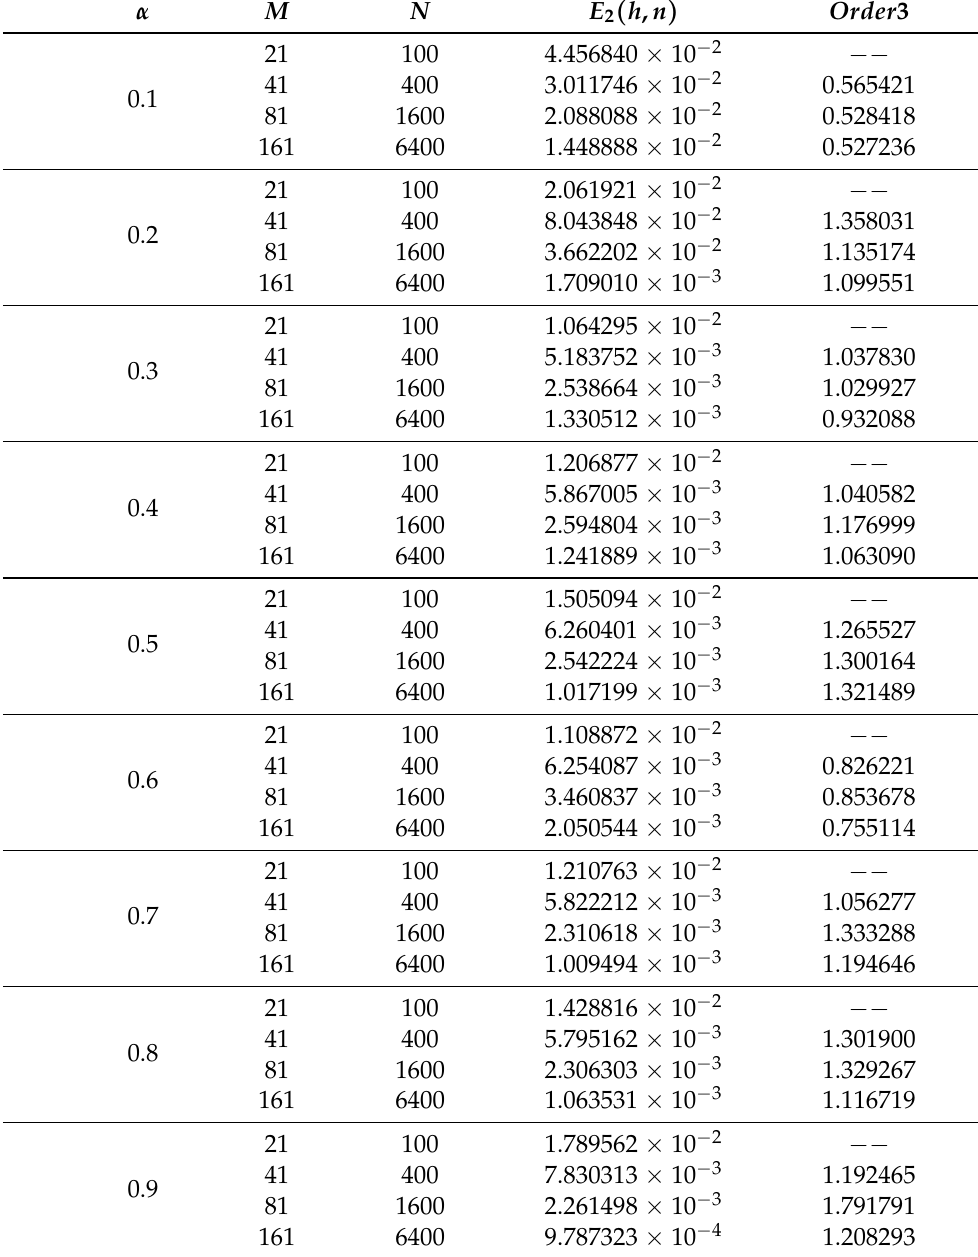
Table 8. Numerical error and spatial convergence order of HASC-N difference scheme for Example